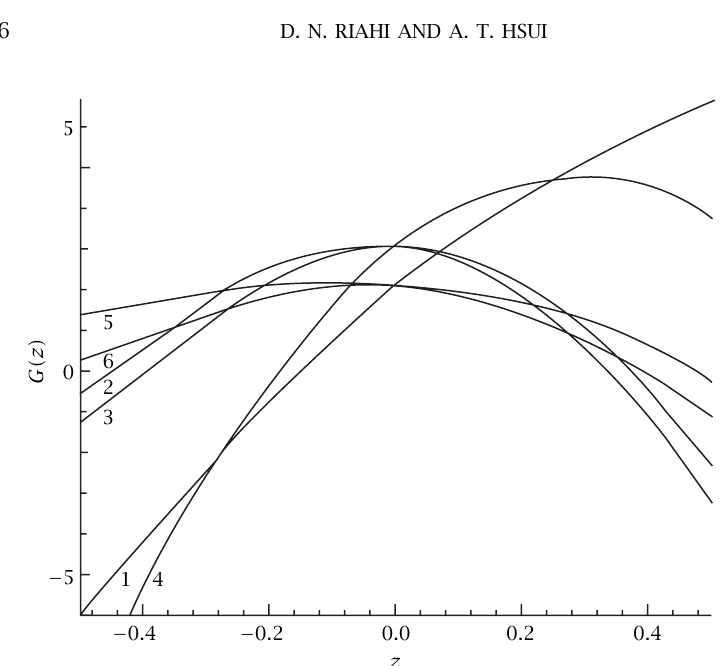
Figure 1.1 . The gravity function G(z) versus z for G 2 < 0. Each curve is labeled by a number given just below the curve. The curves 2, 3, and 4 are for G 2 = − 14 . 5 and correspond, respectively, to G 1 = − 5 / 3 , 0 . 0, and 12 . 0. The curves 5, 6, and 1 are for G 2 = − 3 . 0 and correspond, respectively, to G 1 = − 5 / 3, 0 . 0, and 12 .